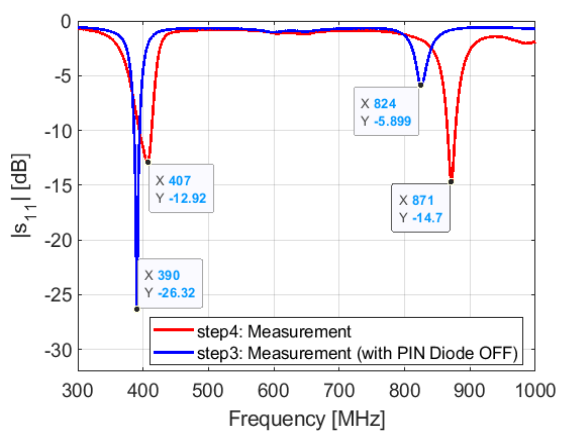
Figure 17. Measured S11 in steps 3 (with PIN diode) and 4.